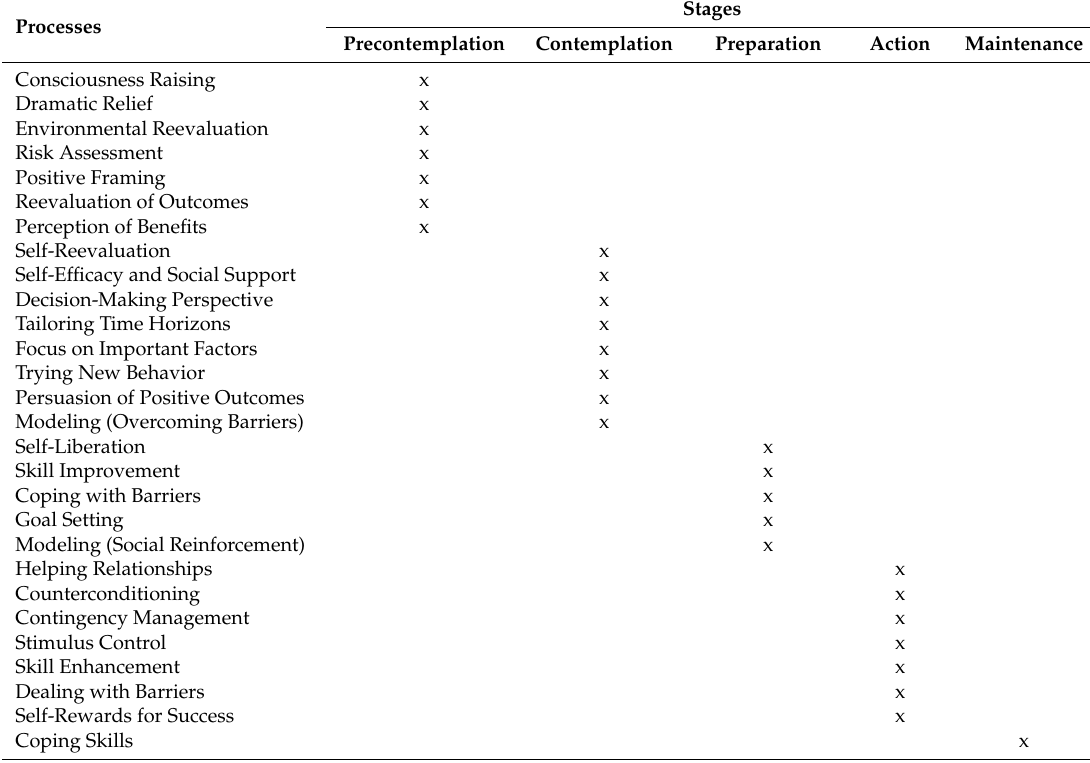
Table 1. Overview of the stages and processes of change (Adapted from “Planning Health Promotion Programs: An intervention mapping approach.” by Bartholomew et al.